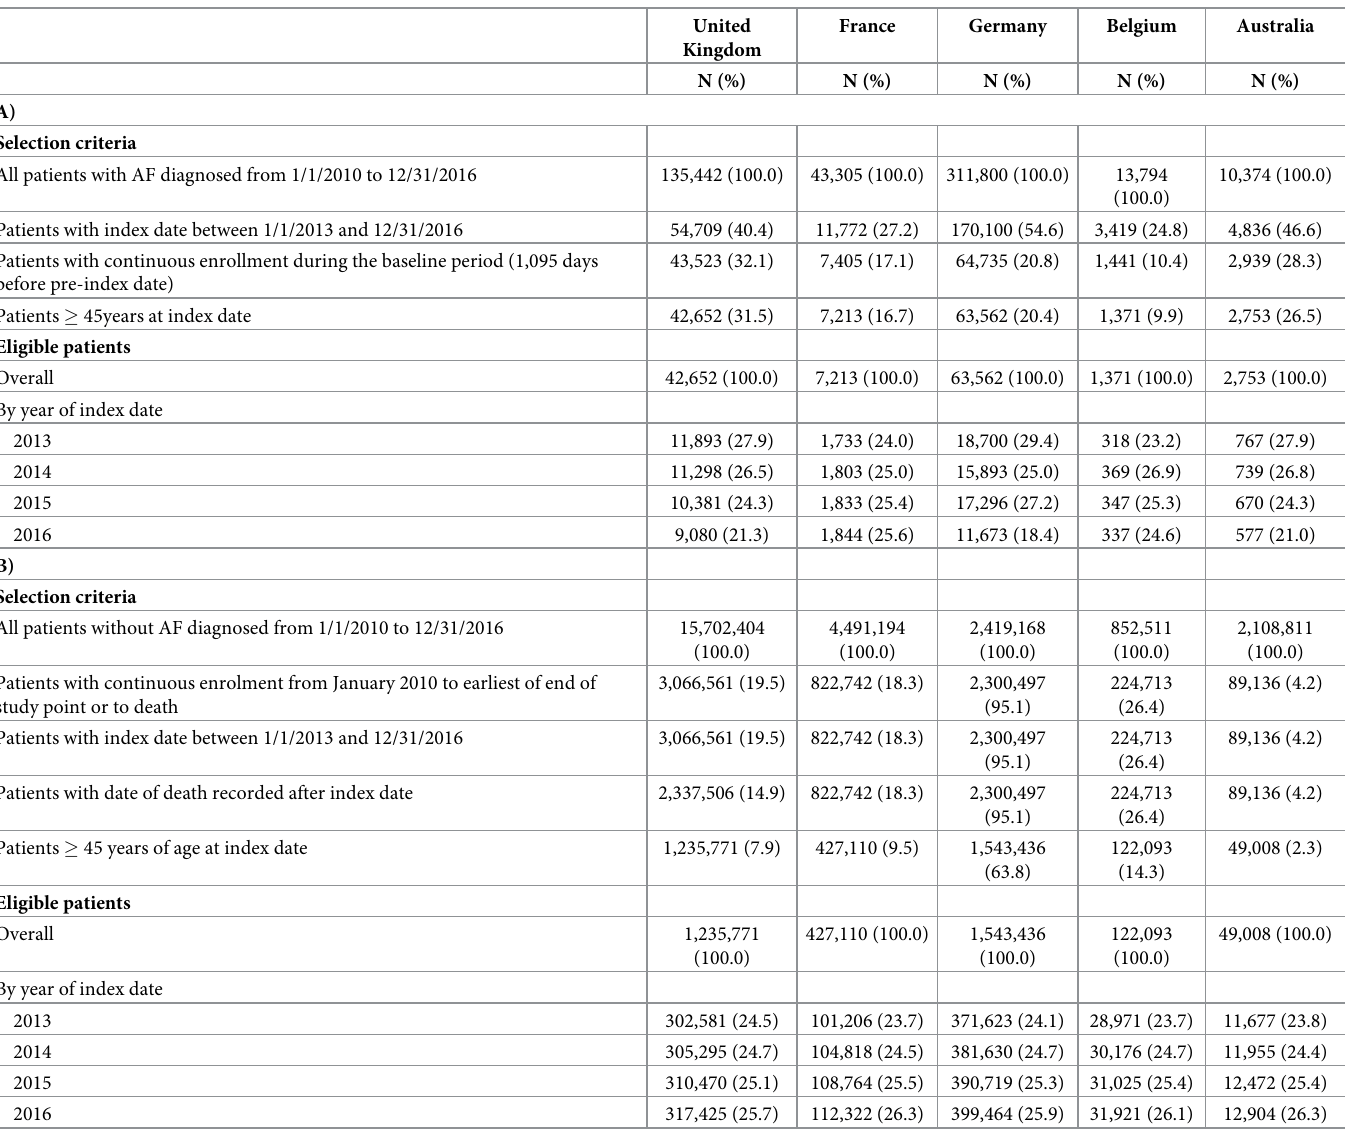
Table 1. Attrition in all databases among A) cases and B)